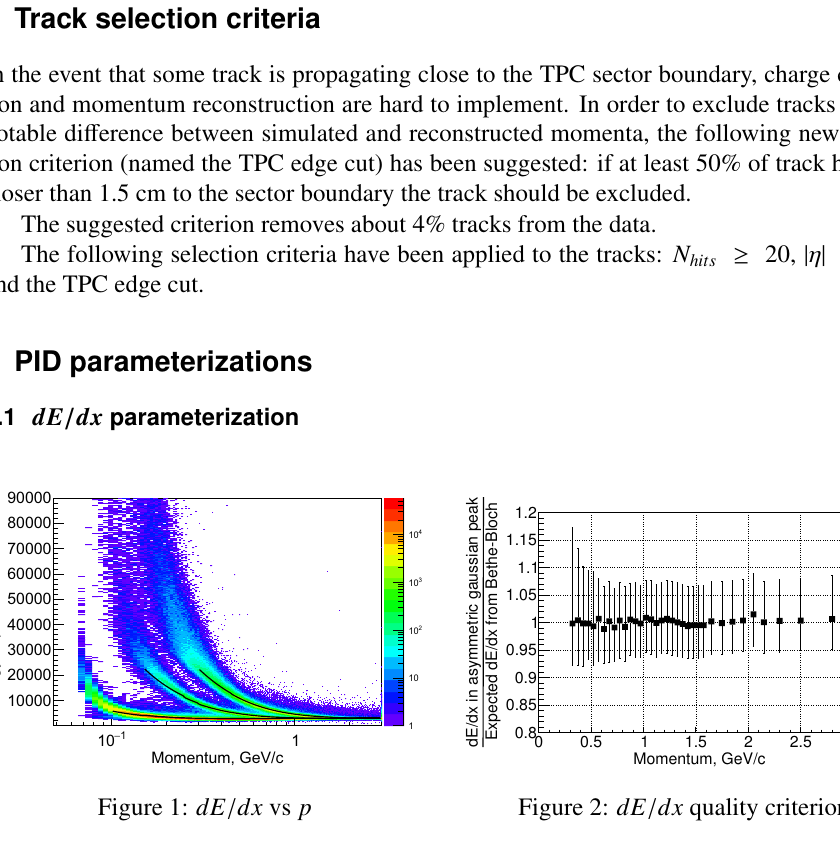
Figure 1: dE / dx vs p